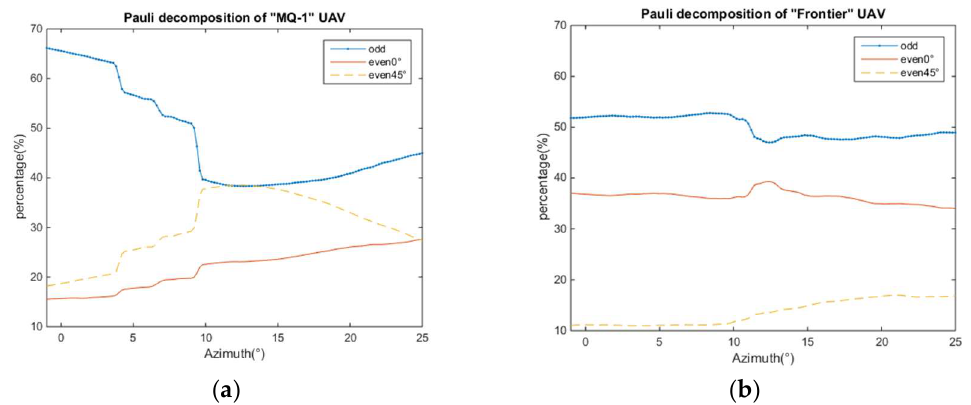
Figure 11. The proportions of scattering Pauli decomposition mechanisms of “MQ-1” and “Frontier” UAVs. ( a ) “MQ-1” UAV; ( b ) “Frontier” UAV.